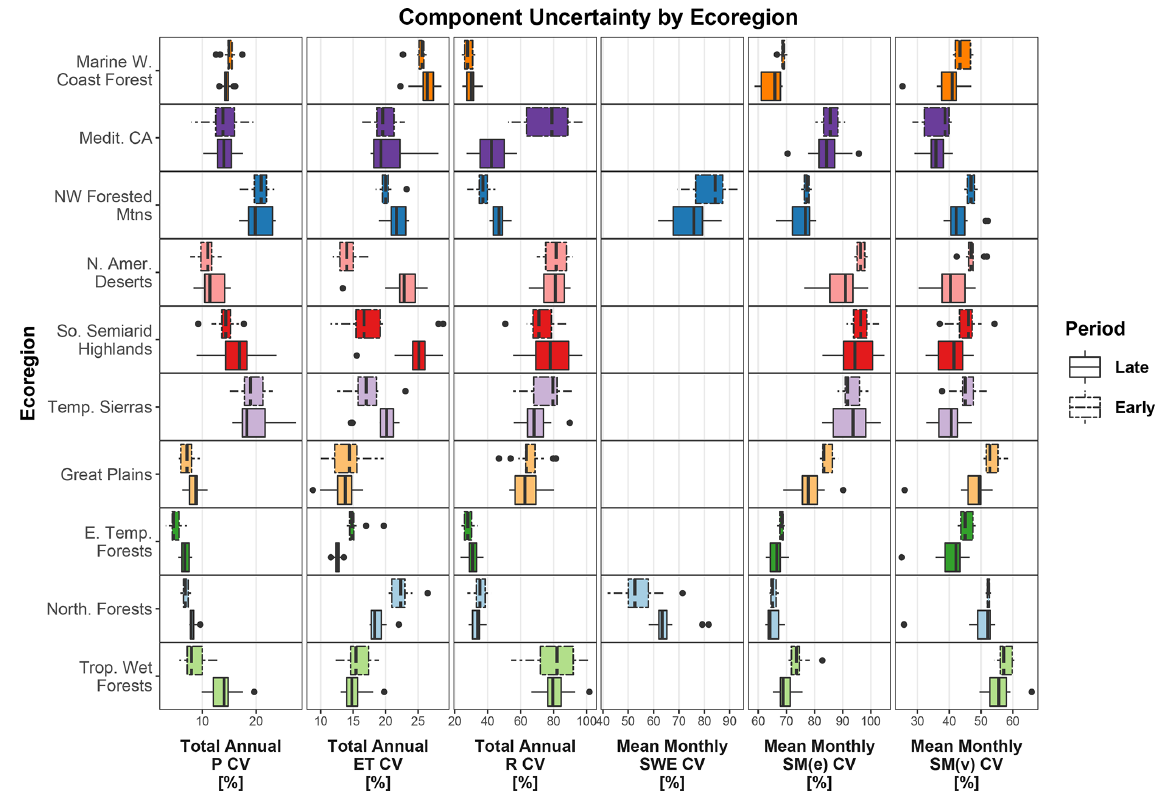
Figure 5. Box plots of uncertainty, measured as annual coefficient of variation (CV), between component estimates at 10 ecoregions. CV distributions are subdivided into late and early periods, i.e., 1985–1999 and 2000–2014. Box lower limits, midlines, and upper limits represent the 25th, 50th (median), and 75th percentiles, respectively, of the associated data. Whiskers represent 1.5 times the interquartile range. Box colors denote the ecoregion and correspond to the map colors in Fig. 1. Components displayed are precipitation ( P ), evapotranspiration (ET), runoff ( R ), snow water equivalent (SWE), soil moisture in units of equivalent water depth (SM( e )), and soil moisture in units of volumetric water content (SM( v )). Results for SWE uncertainty are omitted for ecoregions with limited annual